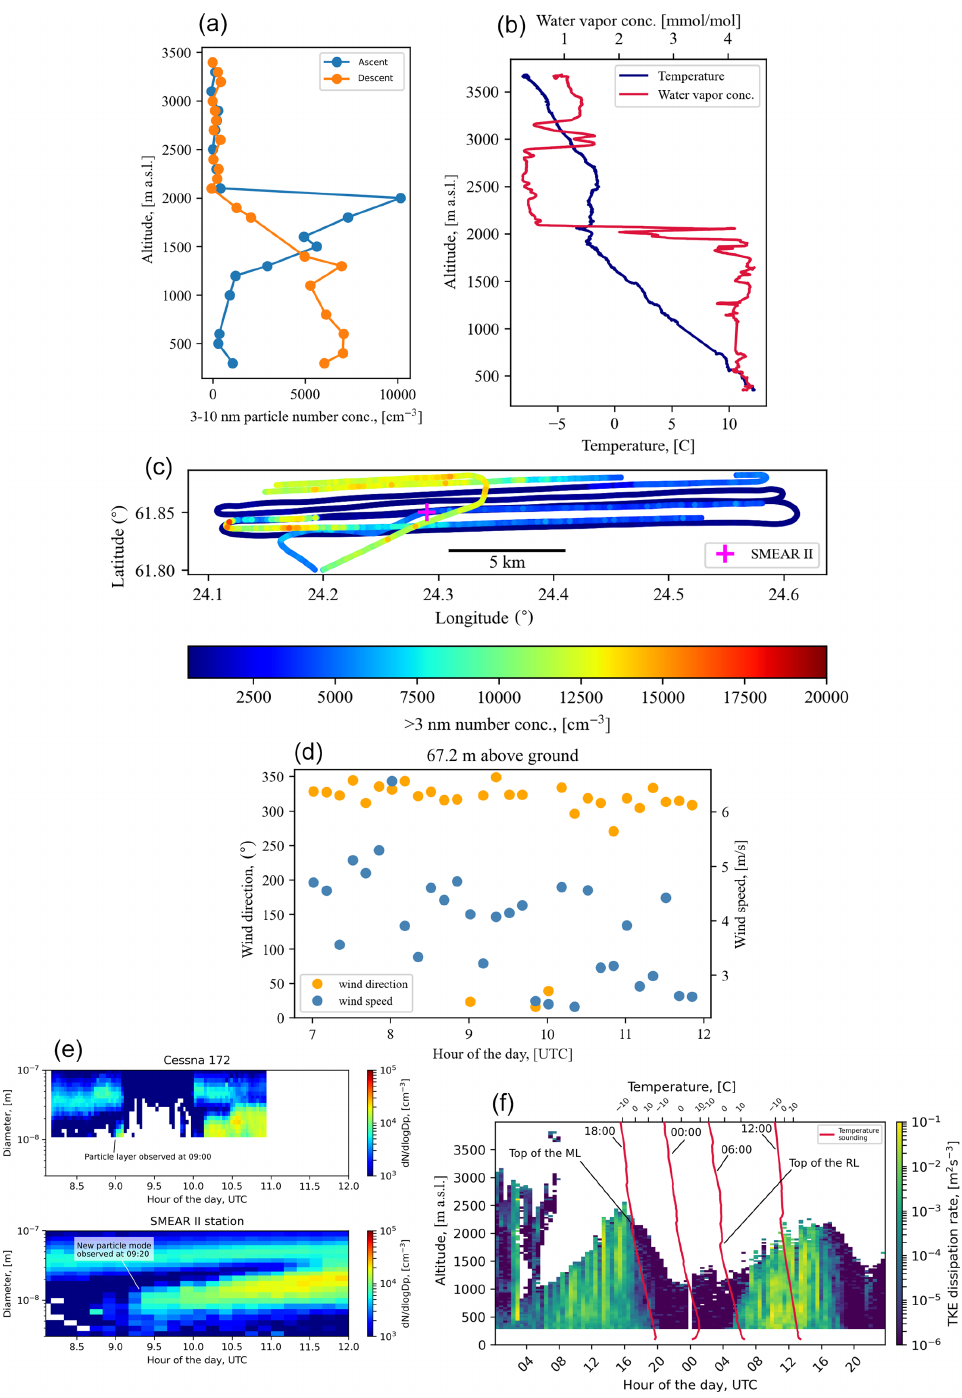
Figure 4. Panel (a) shows vertical profiles of 3–10nm particle number concentration on 19 May 2017 between 08:42–10:24UTC. Panel (b) shows the temperature and water vapor concentration profiles during the ascent. Panel (c) shows the afternoon flight track colored by > 3nm particle number concentration. Panel (d) shows the wind direction and speed measured from the SMEAR II mast at 67.2m. Panel (e) shows the particle number size distribution from the measurement airplane and the SMEAR II station. Panel (f) shows the turbulent kinetic energy (TKE) dissipation rate measured by the Doppler lidar in Hyytiälä between 18–19 May 2018. Temperature soundings from Jokioinen are